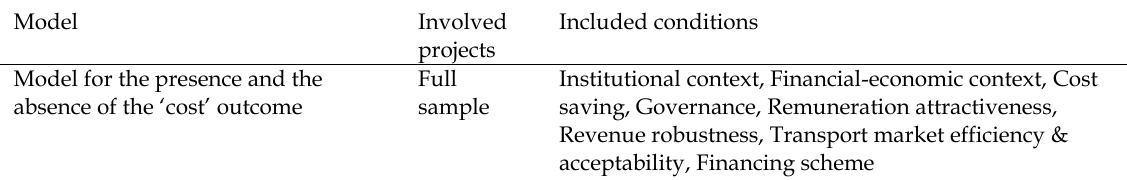
Initial model tested for the full sample analysis Model Involved Included conditions projects Model for the presence and the Full Institutional context, Financial-economic context, Cost absence of the ‘cost’ outcome sample saving, Governance, Remuneration attractiveness, Revenue robustness, Transport market efficiency & acceptability, Financing